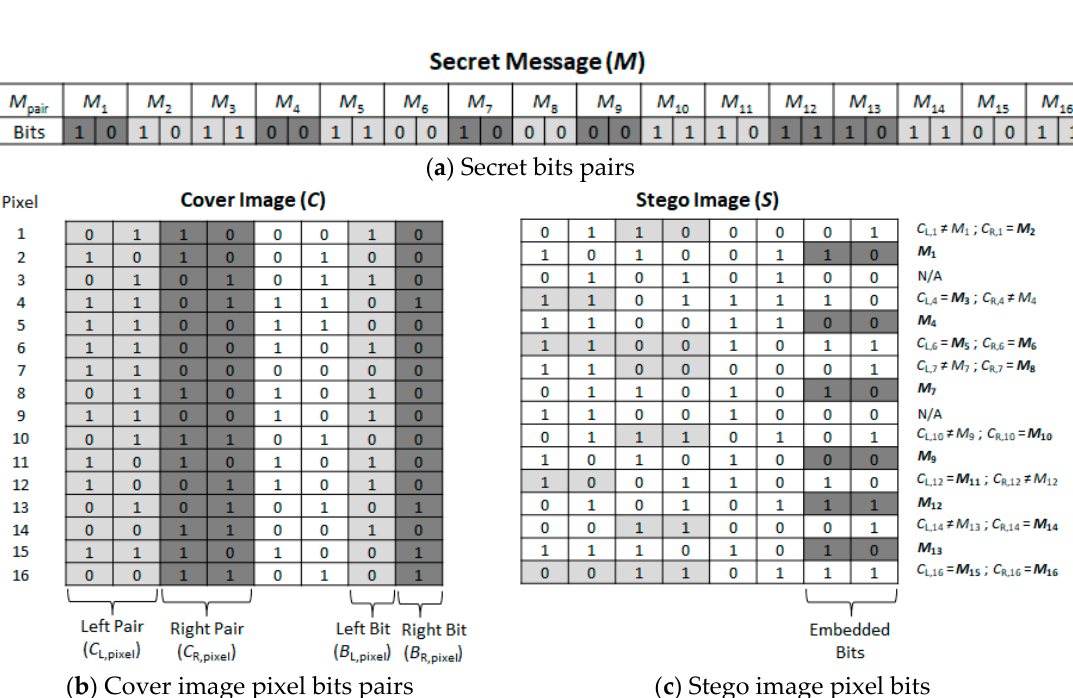
Table 2. The proposed embedding steps.